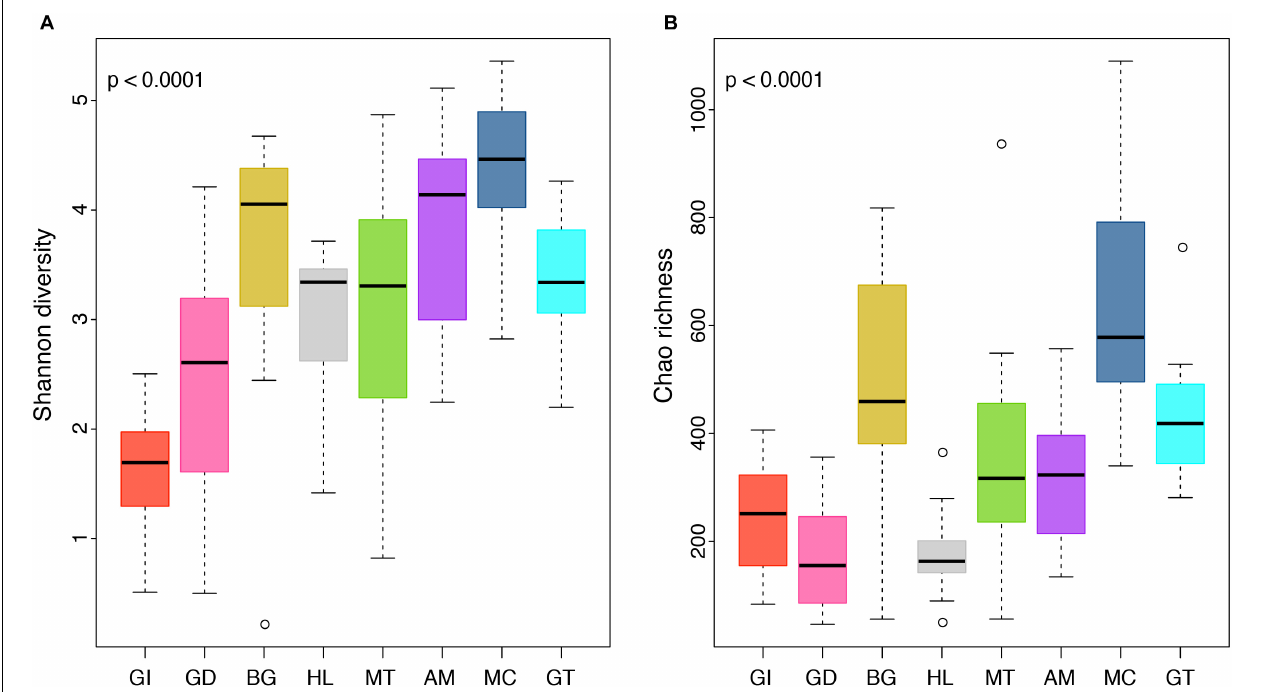
FIGURE 3 | Boxplot displaying differences in community diversity between P. margaritifera tissues. Shannon diversity (A) and Chao richness (B) values are shown for each of the eight tissue types; gill (GI), gonad (GD), byssus gland (BG), haemolymph (HL), mantle (MT), adductor muscle (AM), mucus (MC), and gut (GT). Boxes display the first and third quartile spread of the data, with the line in the box indicating the median, the whiskers denoting the minimum and maximum values and open dots as outliners of the data. P -values indicate significant differences in community diversity between tissues (ANOVA and Kruskal–Wallis tests).